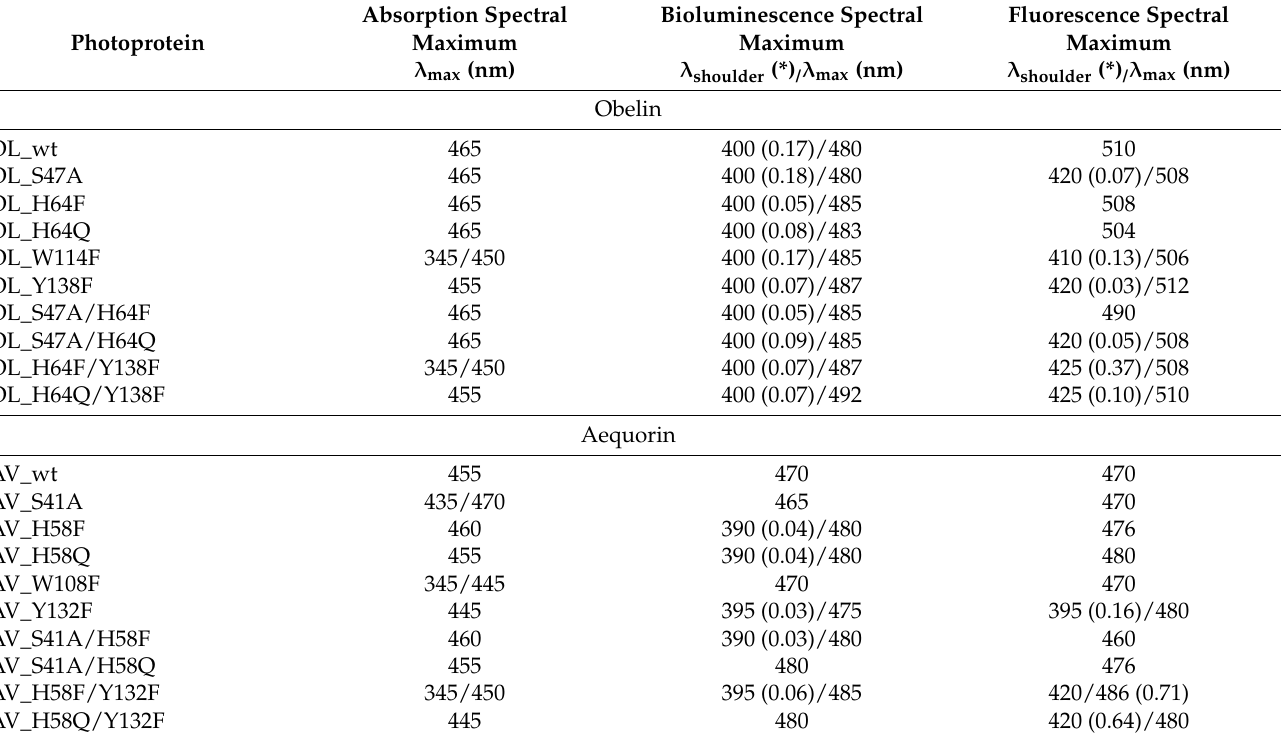
Table 2. Spectral properties of obelin and aequorin